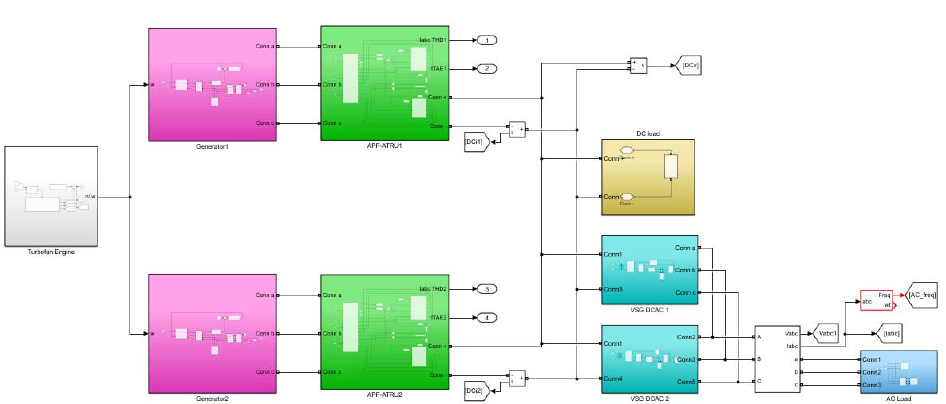
Figure 12. Simulation platform of MEA power control